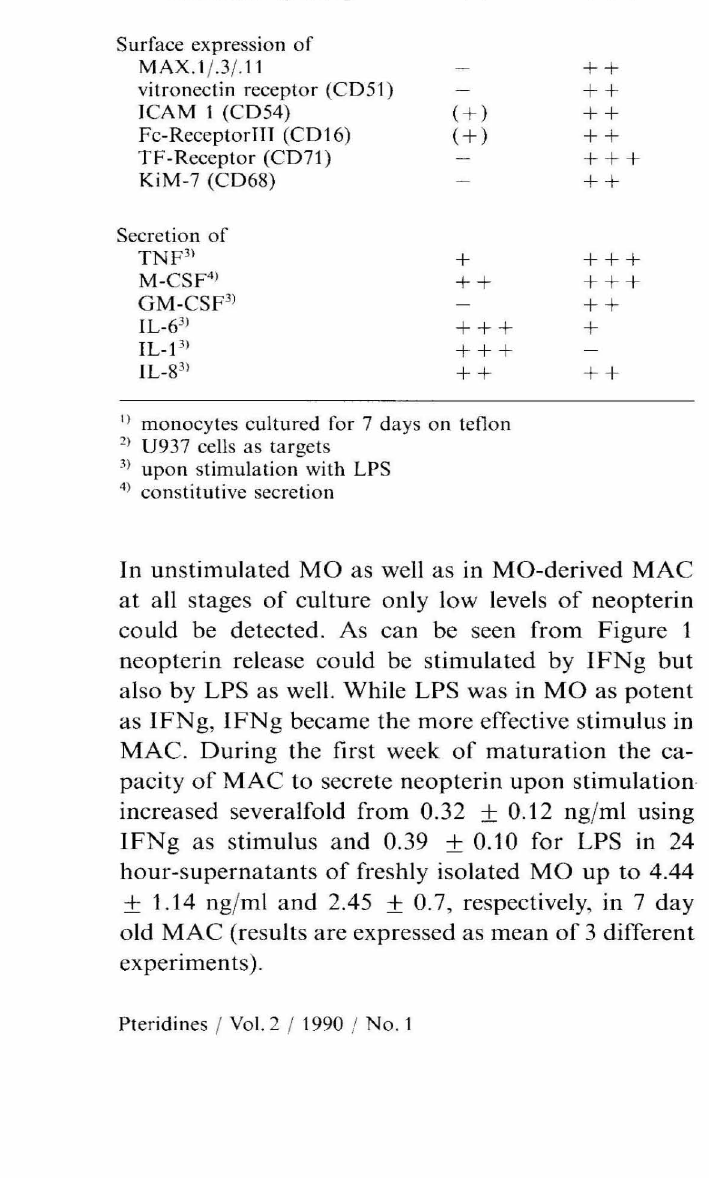
tumorcytotoxicity 2) - stimilated by IFNg Procoagulant activity - stimulated by IFNg 0 2-Production (PMA-induced) - stimulated by IFNg Surface expression of MAX.l j.3/.11